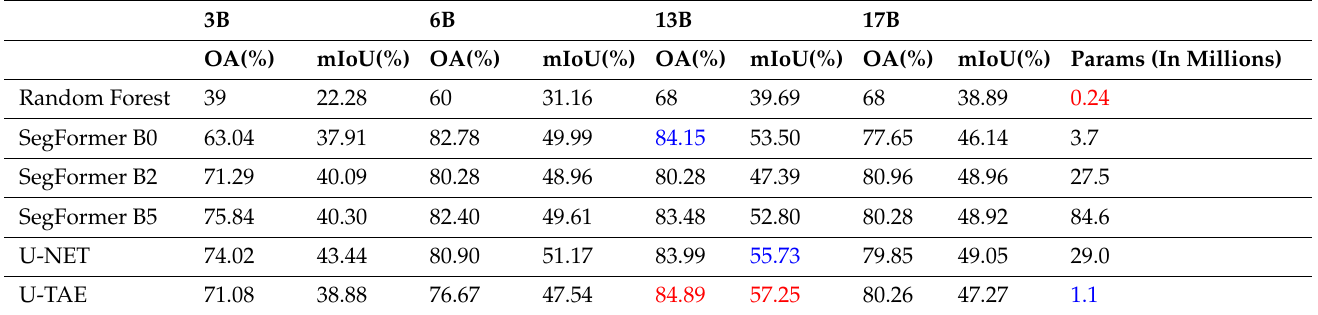
Table 2. Comparisons between the three deep learning models and random forest, with different input band combinations. Highest overall is U-TAE with 13B combination (red), followed by U-NET with 13B combination (blue).